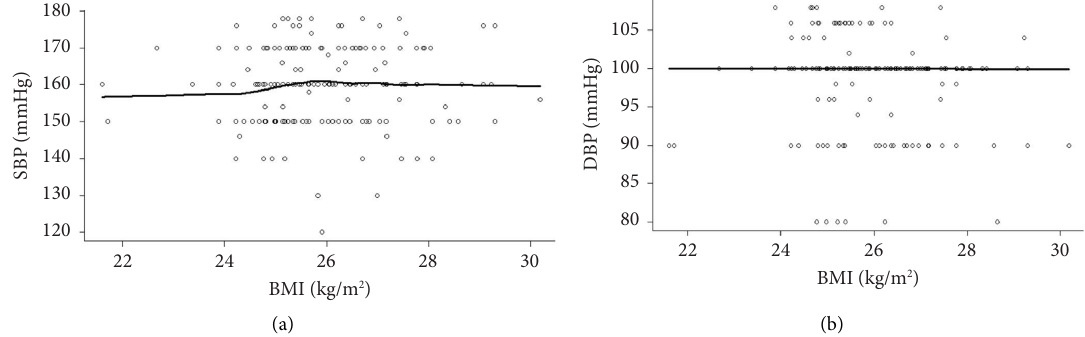
Figure 2: Assessing SBP/DBP baseline in the context of diferent BMIs. (a, b) Te values of SBP (a) and DBP (b), respectively, in the context of diferent